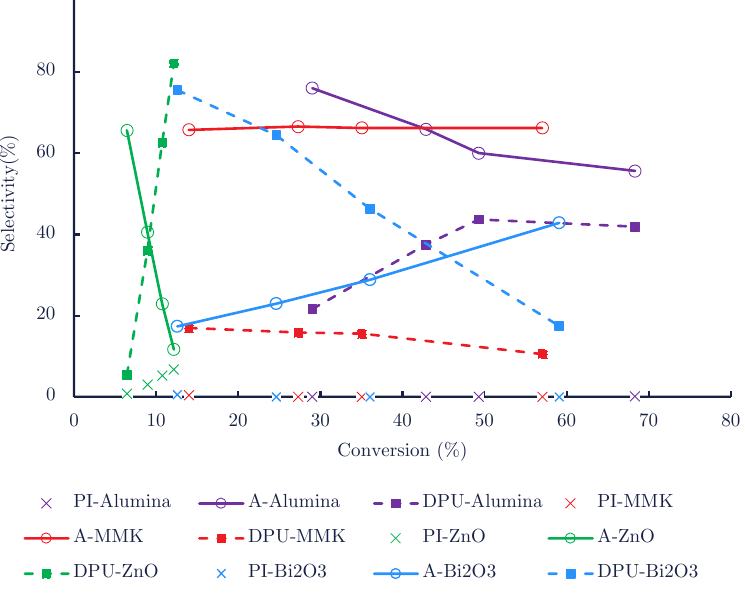
Figure 3. Selectivity vs. conversion in the catalytic tests with MMK, ZnO, Al 2 O 3 and Bi 2 O 3 . These three products, aniline, DPU and the traces of PI, when observed, accounted for most of the converted MPC. However, minor additional products seem still to form at high conversion, as can be witnessed by the slight but significant drop in mole balance from ∼ 100 to ∼ 90 mol% for Al ∼ 80% for MMK and Bi 2 O 3 and 2 O 3 , as the conversion increases to 100 mol% (Figure 4). These unidentified by-products could consist of heavy products made by the slow condensation of DPU or rapid condensation of PI with themselves, one another or with unconverted MPC, some being illustrated in Scheme